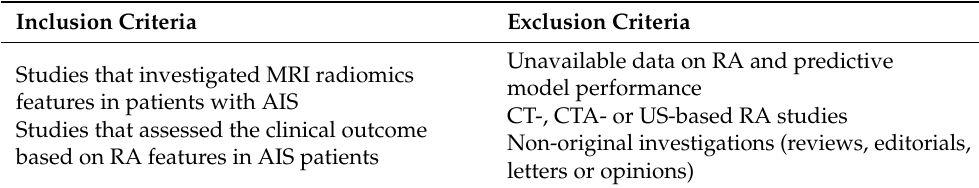
Table 1. Inclusion and exclusion